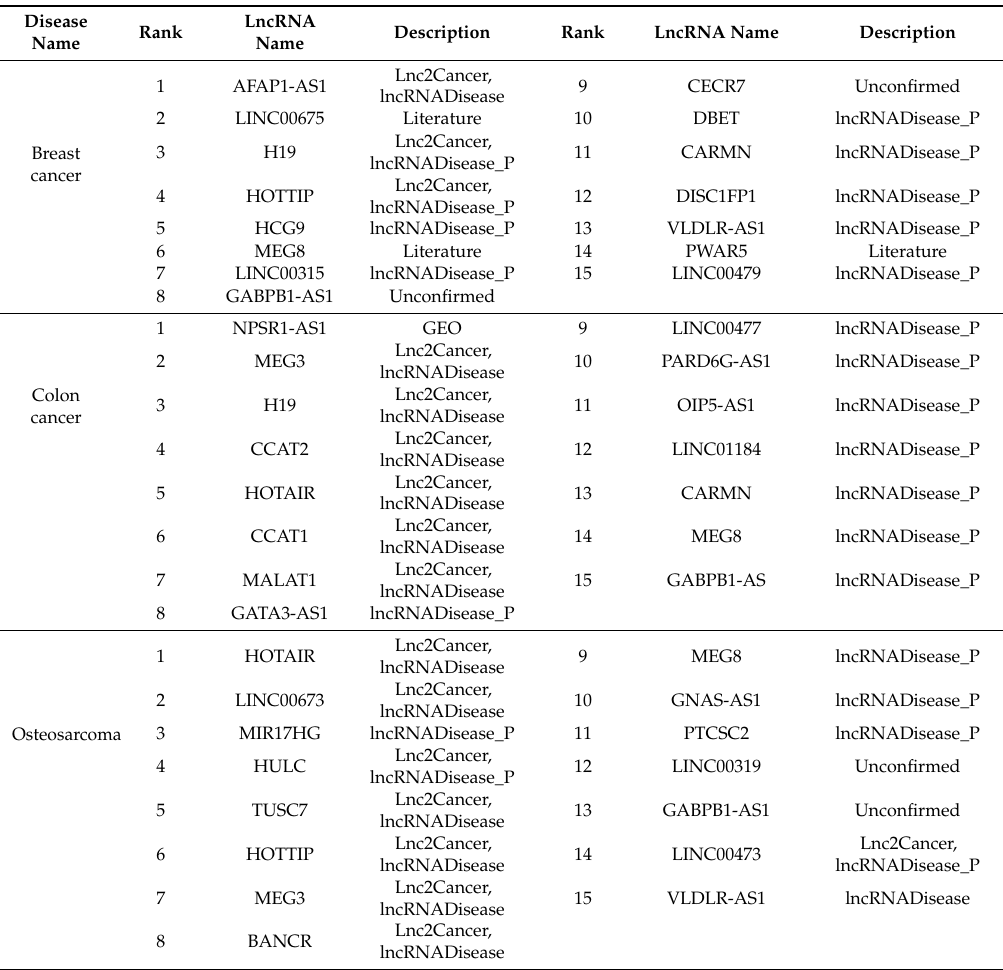
Table 4. Candidate long non-coding RNAs (lncRNAs) associated with breast cancer, colon cancer, and